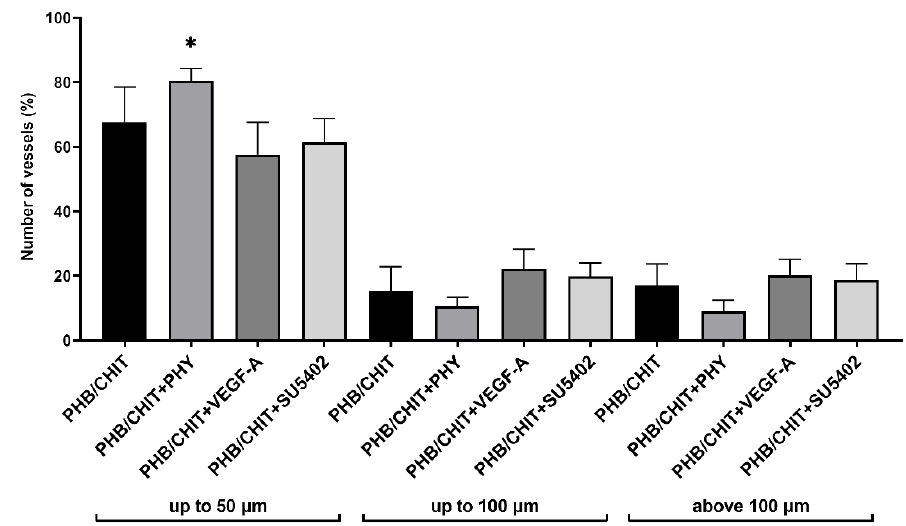
Figure 5. The percentage number of blood vessels of the CAM tissue around the PHB/CHIT scaffolds depending on the diameter of the vessels and treatment of the scaffold. Experiments were repeated three times, and data are shown as mean in % ± SD (biological replicates: 6 samples for each group, technical replicates: 120 for each group). * p < 0.0001. Table 4. Thickness of the CAM layers. Data are presented as a thickness of each layer in µm ± SD of n = 3 independent experiments. Experimental groups included six samples of the scaffolds for each group.